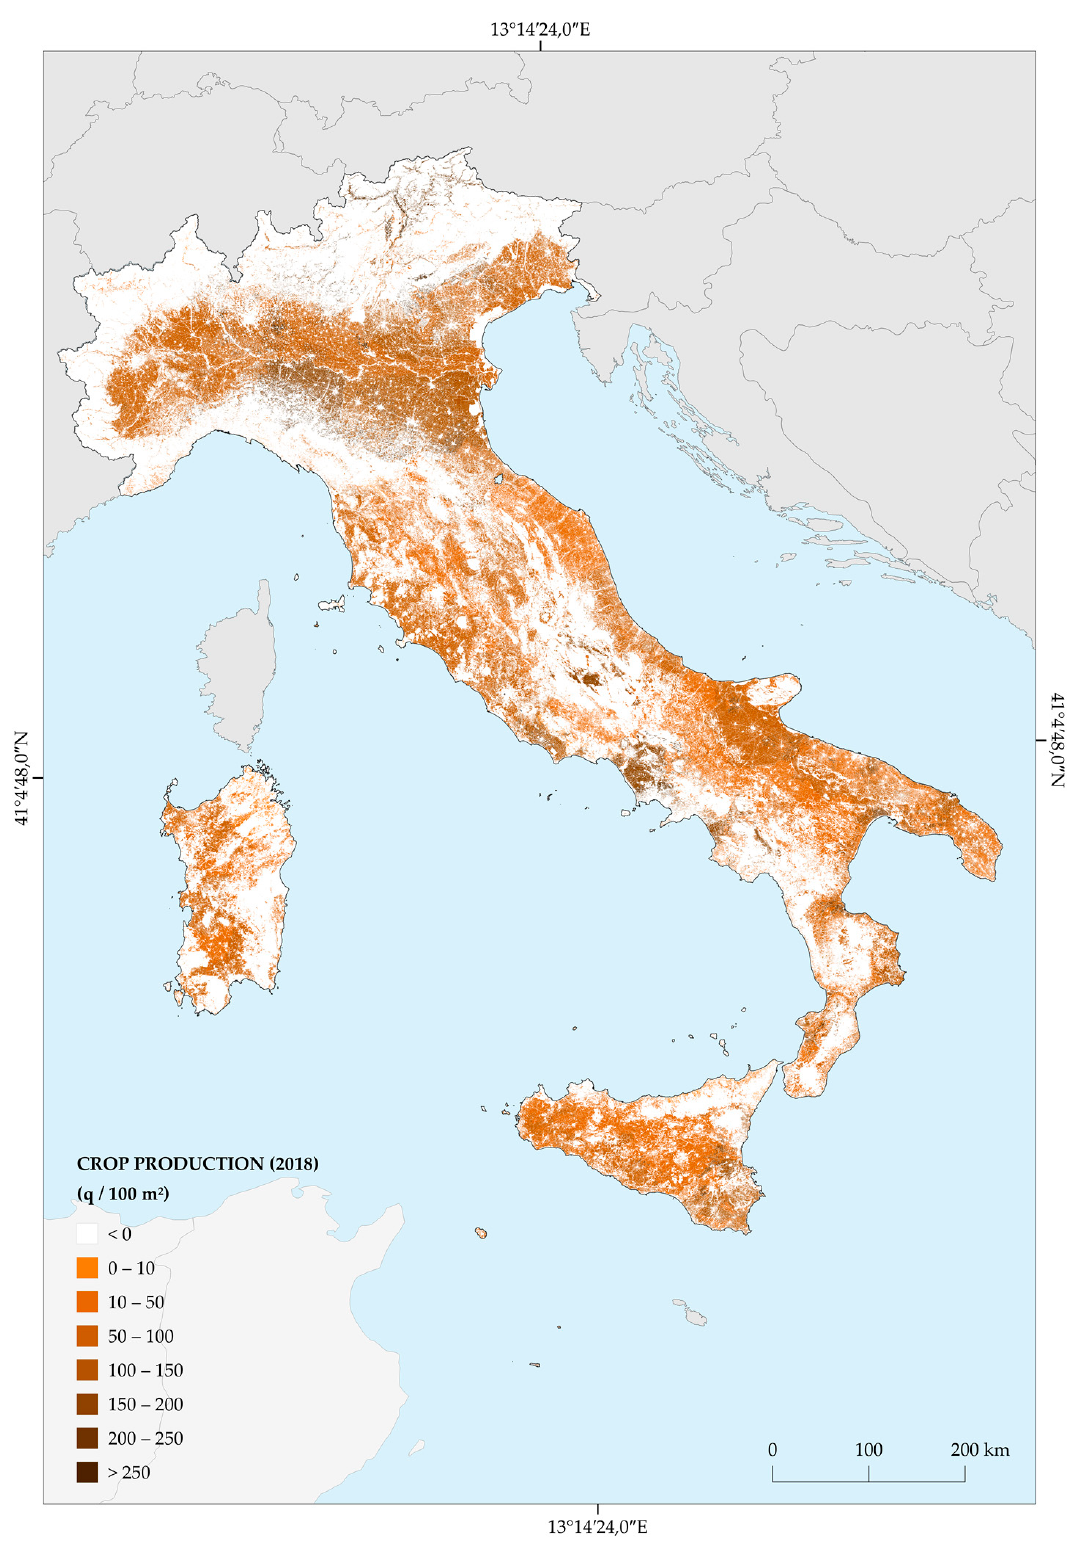
Figure 6. Crop production (2018).